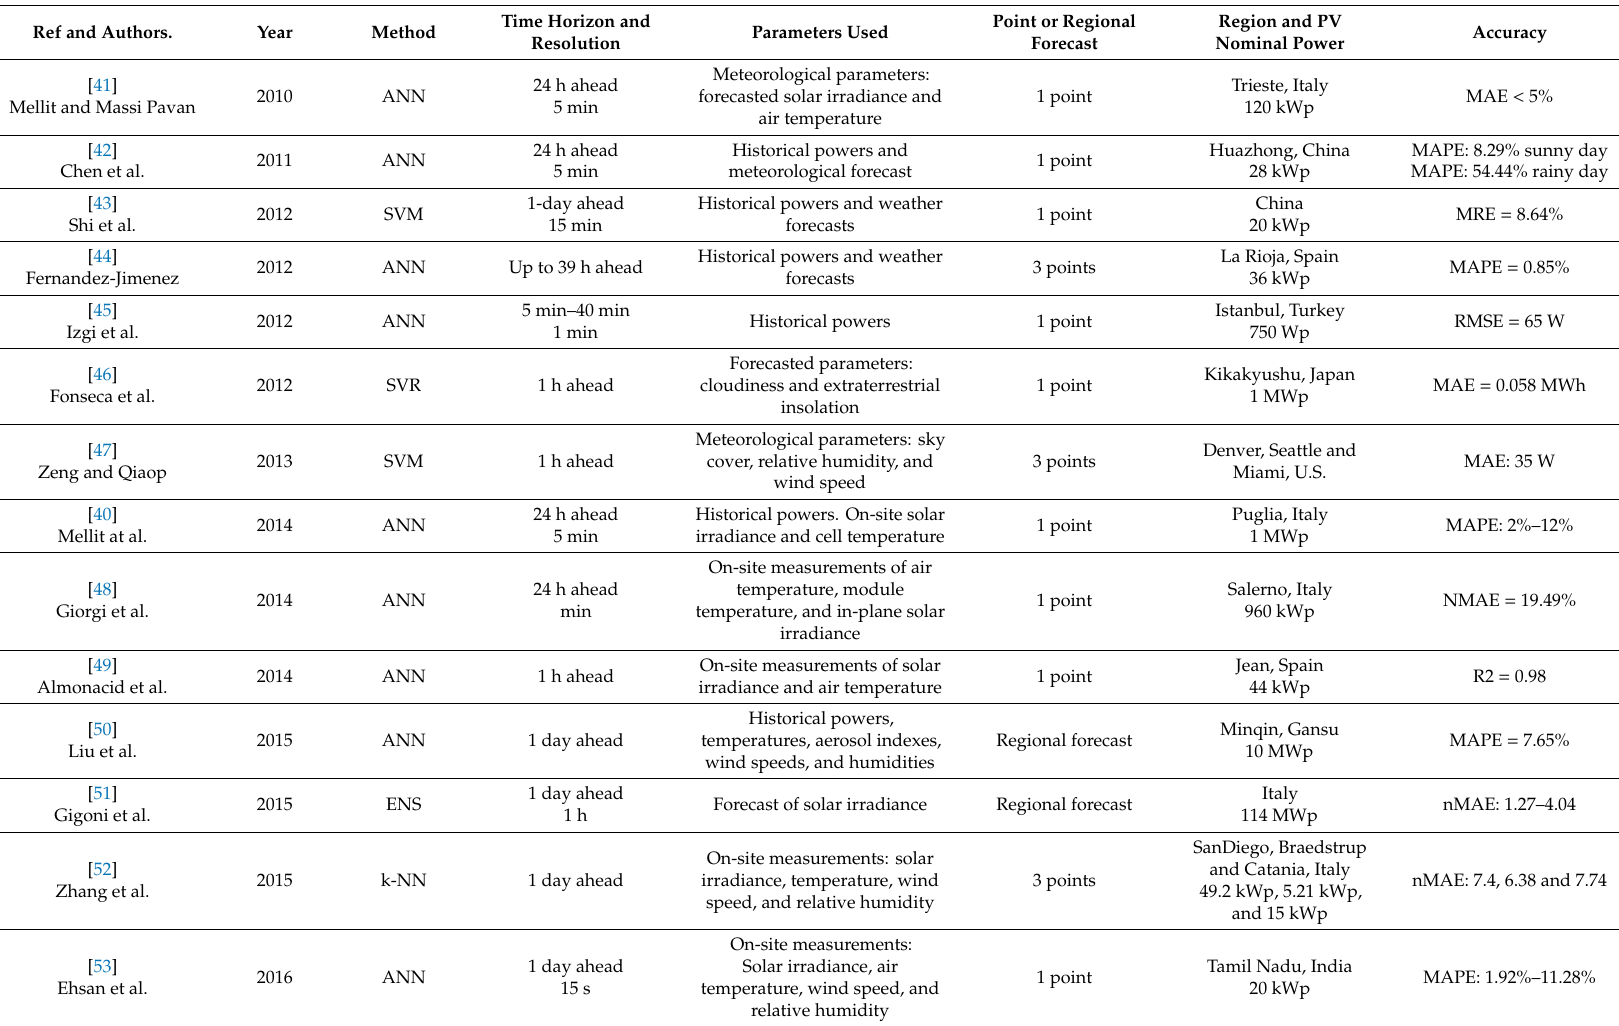
Table 2. Machine learning (ML)-based methods for the forecast of PV power-period 2010–2019. Ref and